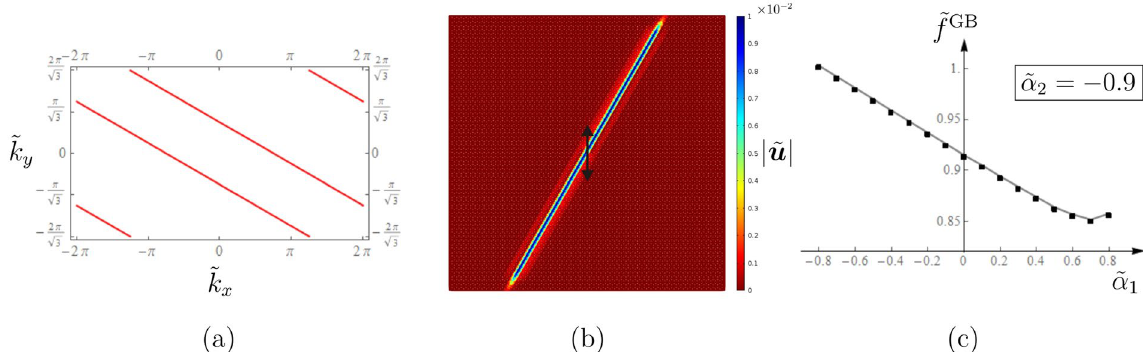
Figure 5. ( a ) Slowness contours and ( b ) amplitude field of the total normalised displacement, determined at = = .   f f 0 86 GB in a gyro-system with different spinners α α = . = − .   ( 0 8, 0 9) ; ( c ) dependence of the 1 2 Gaussian beam frequency on the spinner constant α  when α = − .  0 9 . The geometry of the lattice in ( b ) is the 1 2 same as in Fig. 4b; the harmonic displacement has amplitude 0.01 and it is imposed on a node attached to a spinner with α α =   2